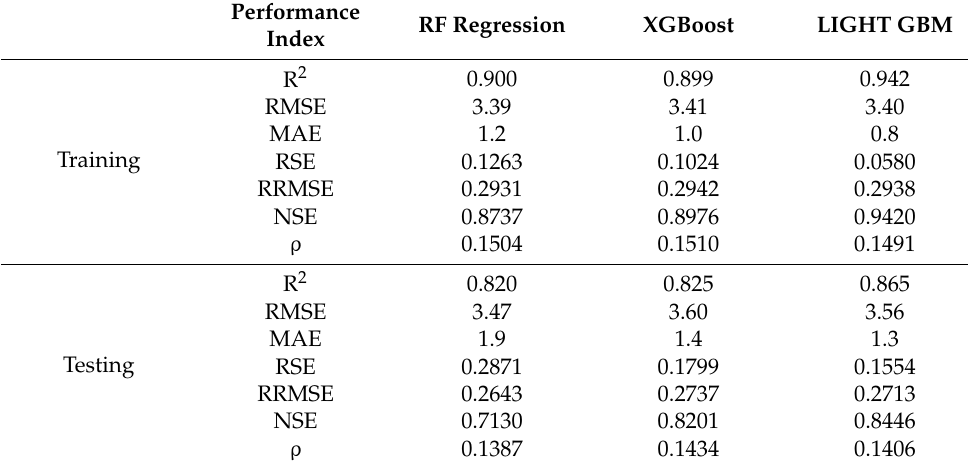
Table 5. Performance index values of the LIGHT GBM and XGBoost models.